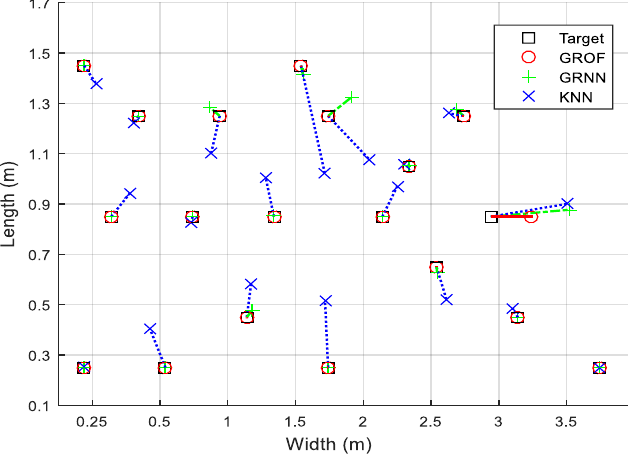
Figure 8. Localization estimation deviation comparison of twenty test points between different algorithms.